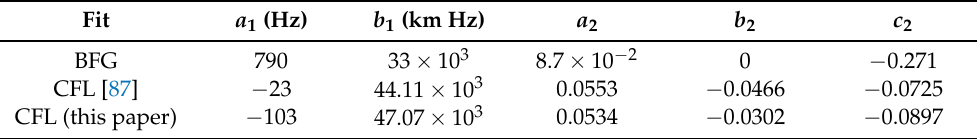
Figure 9. Universal relationships proposed by Andersson and Kokkotas [90] for the f mode, for ν as a function of the mean density ( left panel) and for τ as a function of the compactness ( right panel). In both panels, we also show the BFG [91] and two CFL fits; CFL fit (a) corresponds to the fit calculated in this paper and CFL fit (b) to Flores and Lugones’ fit [87]. Our fit lies, predictably, close to the CFL fit (b). Table 3. Parameters for the BFG [91] and CFL [87] fits related to the f mode in Equations (23) and (24). In the third column, we show the parameters fitting our magnetized CFL